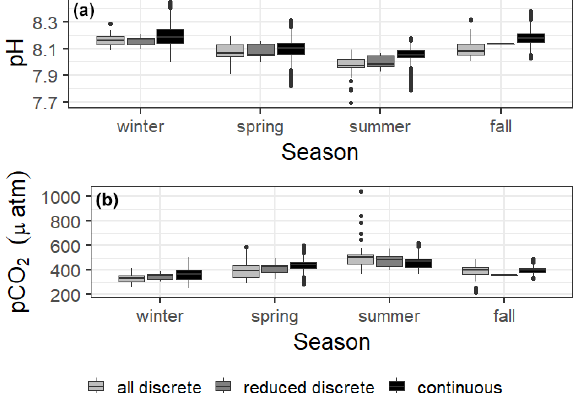
Figure 2. Boxplots of seasonal variability in pH and p CO 2 using all discrete data, reduced discrete data (to overlap with continuous monitoring, 8 November 2016–23 August 2017), and continuous sensor data.